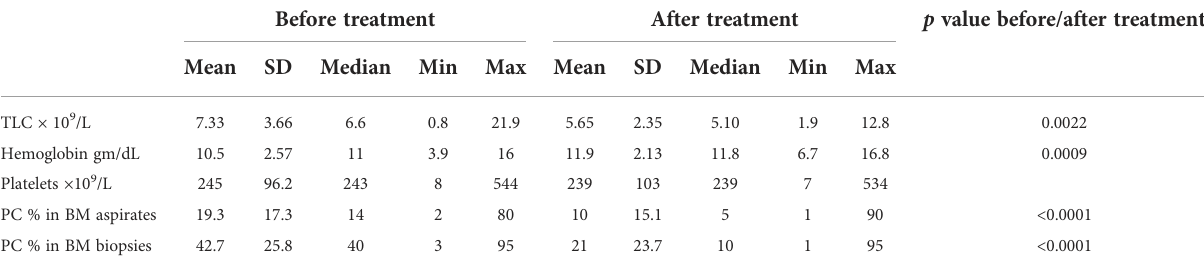
TABLE 4 Peripheral blood and bone marrow fi ndings of the MM patients at initial diagnosis and during follow-up after treatment. Before treatment After treatment p value before/after